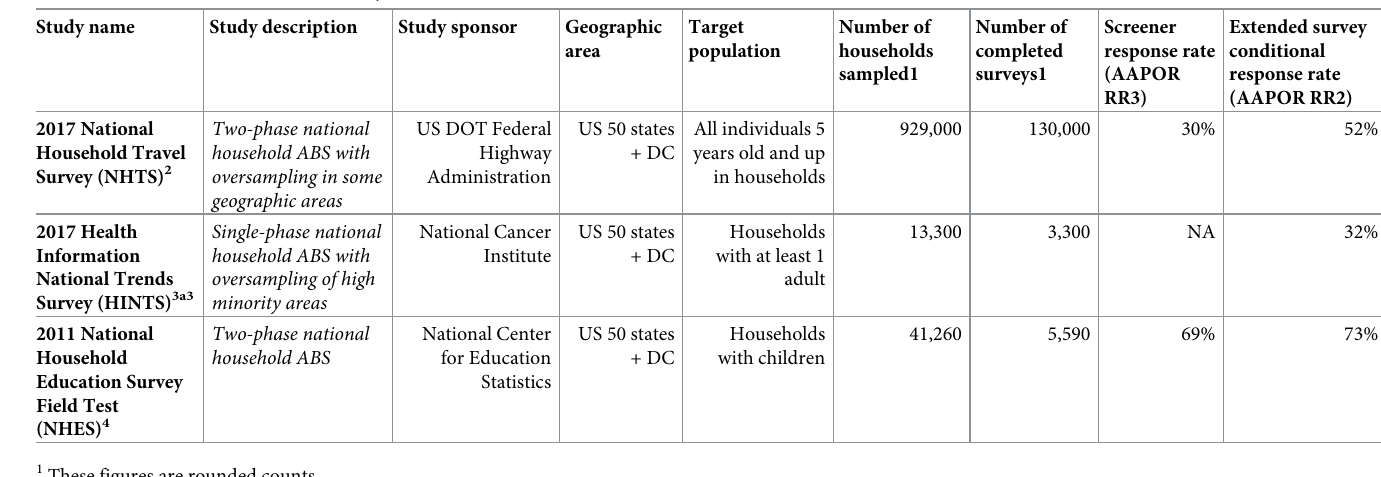
Table 1 contains details of the three studies we used for the analyses. See the S1 Appendix for the exact wording of the survey questions used in these analyses.